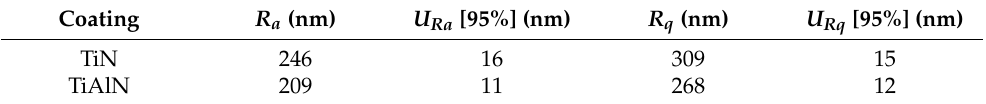
Table 5. The roughness average values of the TiN and TiAlN coatings and their measurement un- certainties.